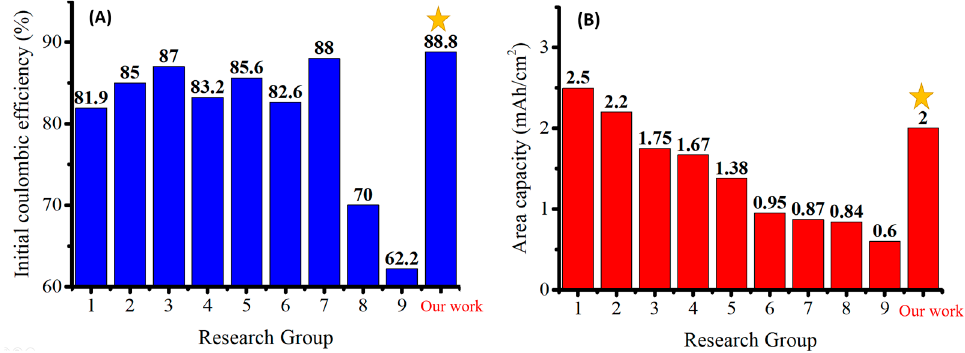
Figure 15. Comparison of ( A ) initial coulombic efficiency and ( B ) areal capacity of selected high- performance anodes reported in the literature. The one marked with star is this work.